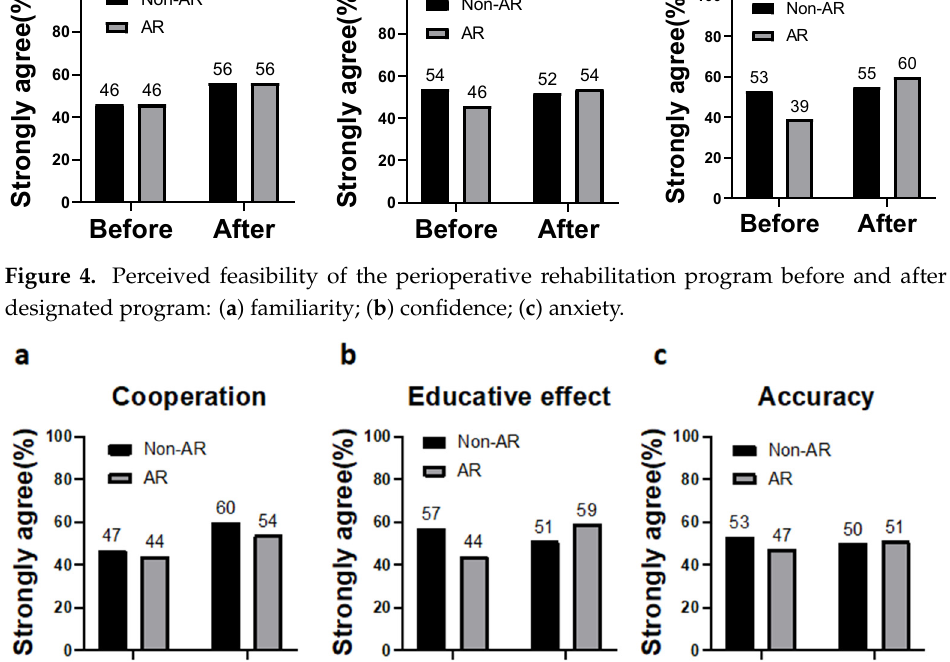
Figure 5. Perceived potency of the perioperative rehabilitation program before and after the desig- nated program: ( a ) cooperation, ( b ) educative effect, and ( c ) accuracy.